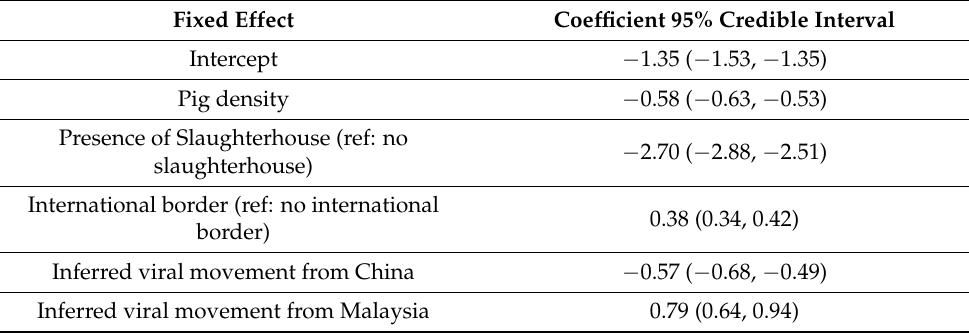
Table 3. Results from the final Bayesian space–time regression based on the phylogeographic matrix (DIC